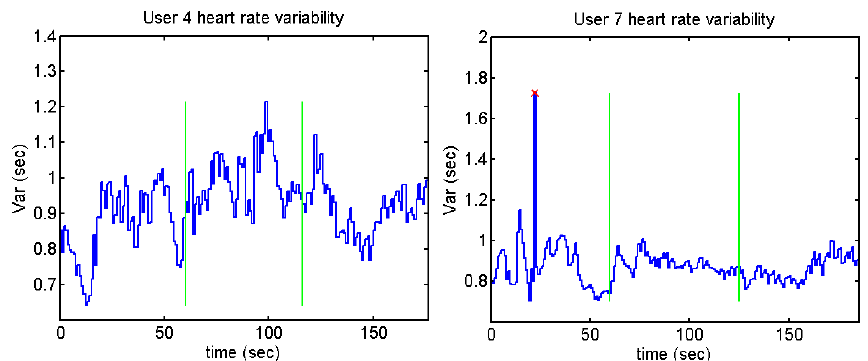
Figure 37. Heart rate variability of User 4 from Stroop Test.